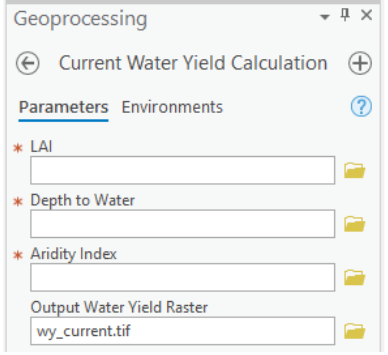
Figure A5. The geoprocessing window when using the Current Water Yield Calculation tool.